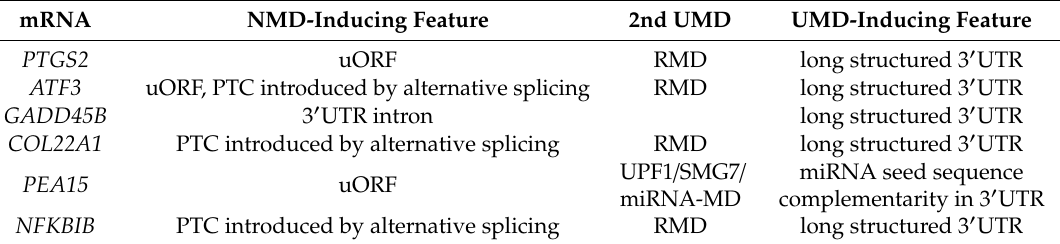
Table 2. Exemplary mRNA targets of more than one